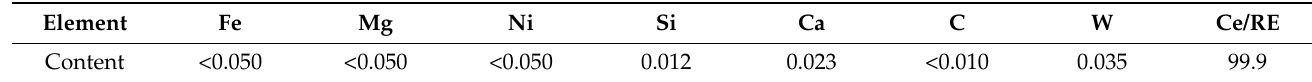
Table 2. Chemical composition of rare earth Ce alloy (wt.%).